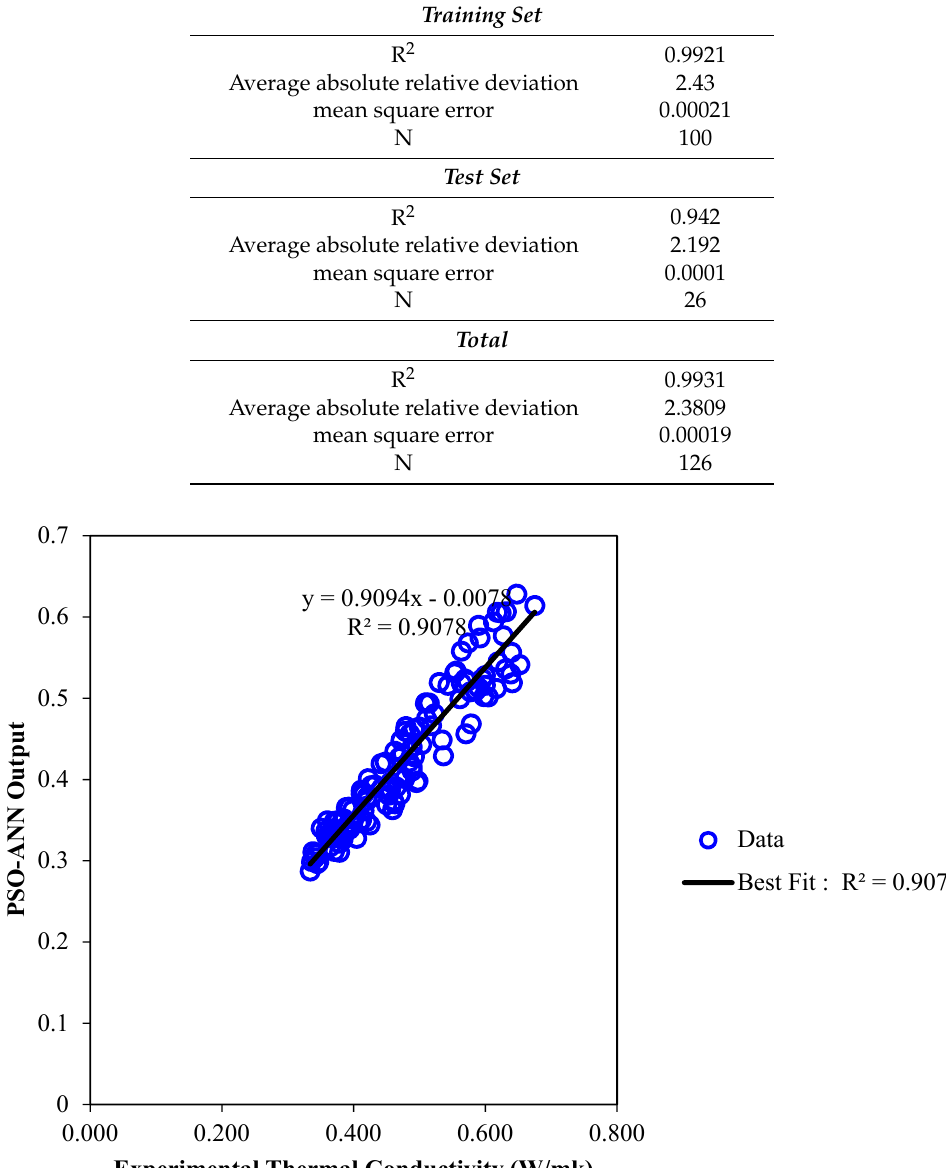
Table 5. Statistical parameters of the evolved LSSVM approach for calculating thermal conductivity of Fe 2 O 3 /ethylene glycol-water nanofluid.